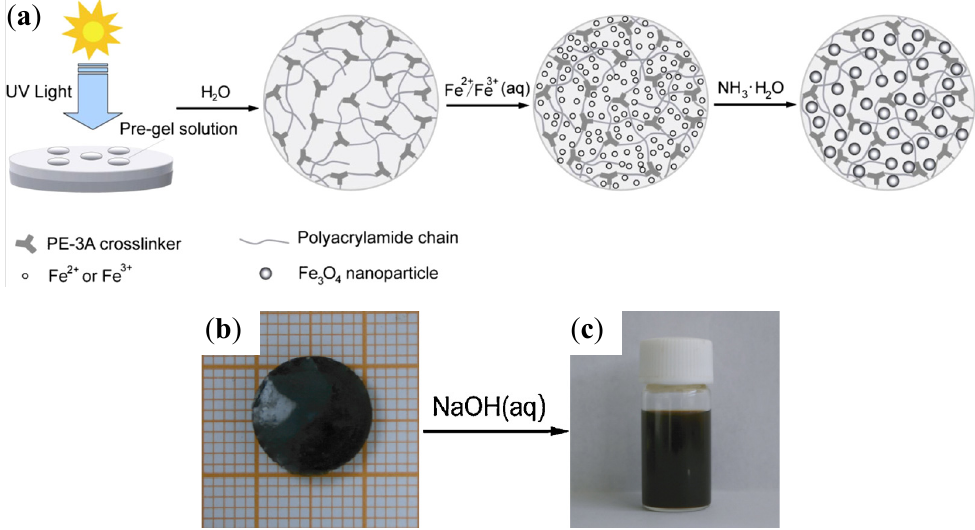
Figure 30. ( a ) Schematic representation; (b) appearance of a magnetic hybrid hydrogel obtained by photo-polymerization and in situ coprecipitation; and ( c ) in the second step, the ferrogel was exposed to NaOH to hydrolyze the cross-link points and induce the release of water-dispersible IONPs. Adapted with permission from [56]. Copyright 2011 Elsevier B.V.